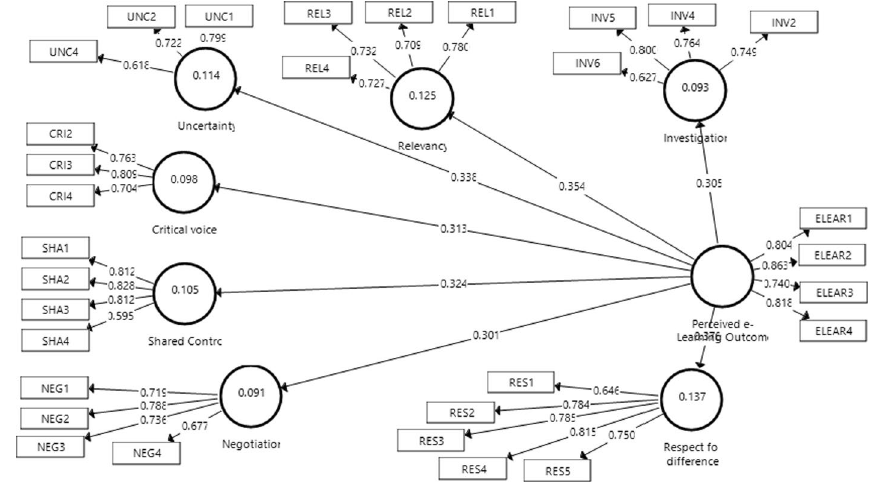
Fig. 1 The measurement model in